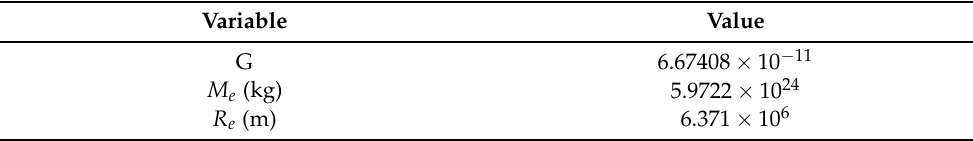
Table 1. Values used in Newton’s Law of Universal